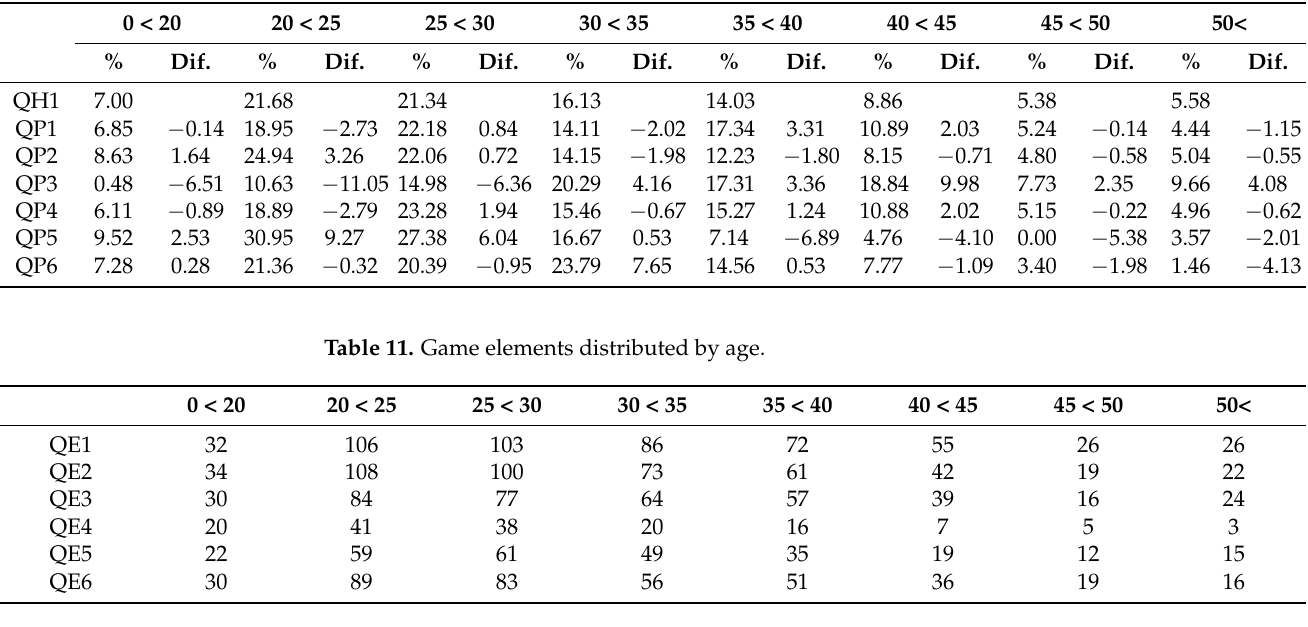
Table 10. Age difference in behavior in games.